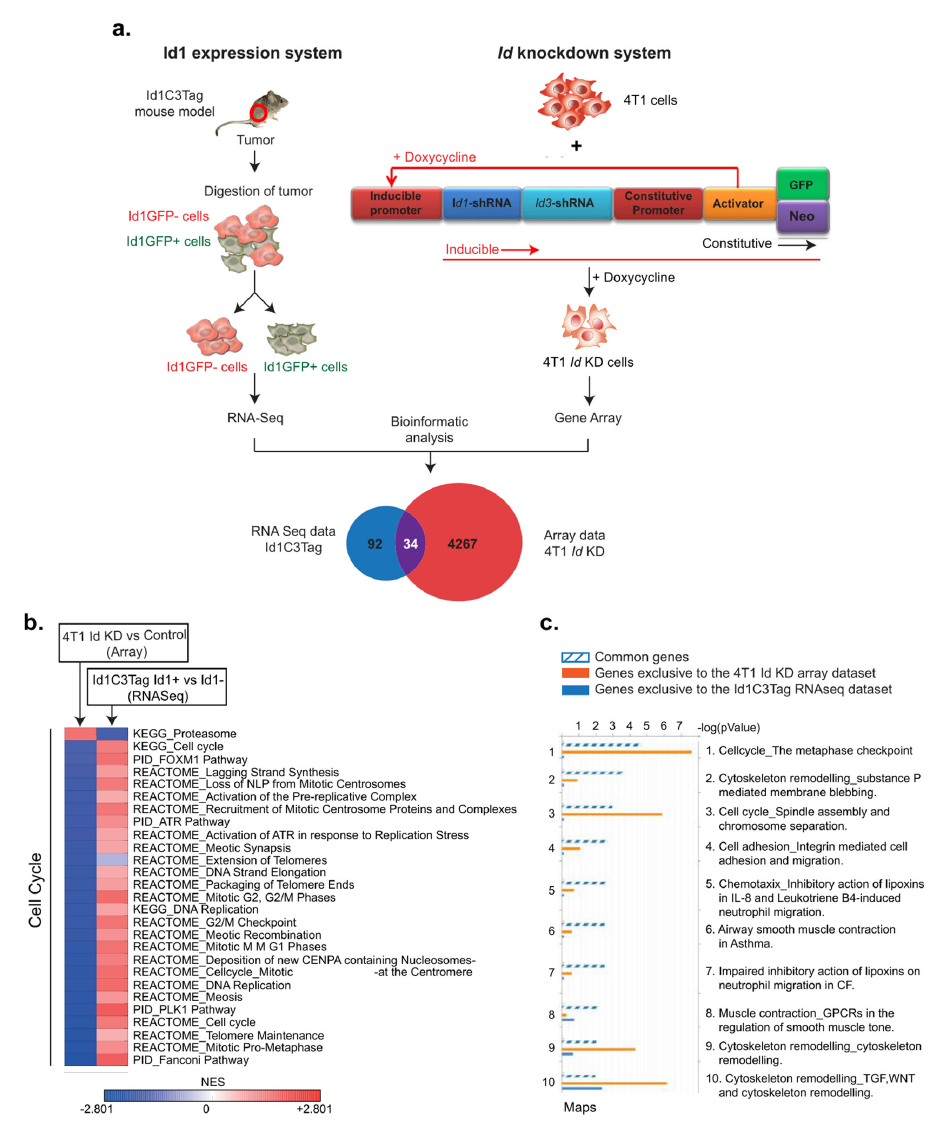
Figure 2. Identification of putative Id-regulated genes. ( a ) To characterize the network of genes regulated by Id proteins, we performed functional annotation analysis on gene array and RNA sequencing data from two different triple-negative breast cancer (TNBC) models marked by either Id depletion or Id1 expression. Aiming to discover high confidence genes involved in the Id gene regulatory network, we compared lists of differentially expressed genes between the Id-expressing or -depleted TNBC models and their controls using MetaCore software. By comparing these two datasets, we generated lists of MetaCore network objects common to both experiments, as well as those unique to each of the two datasets. The data were uploaded in MetaCore and filtered using an adjusted p -value threshold of 0.05, resulting in 4301 network objects that were differentially expressed between the Id KD and the 4T1 control cells. Similarly, the Id1C3Tag RNA sequencing data revealed 126 network objects specific to mouse differentially expressed between Id + and Id- cells. Finally, the genes were mapped to network objects in MetaCore, resulting in a list of 34 genes that were significantly differentially regulated in both models of TNBC. ( b ) To characterize the network of genes regulated by Id, we performed enrichment analysis on the 34 candidate genes, which was visualized by process networks and pathway maps. The enriched pathways included cell cycle, cytoskeleton remodeling, integrin-mediated cell adhesion / migration, and chemotaxis, which are all key steps in epithelial to mesenchymal transition (EMT) and metastasis. ( c ) The cell cycle pathway had the highest score in the genes common to both datasets analyzed, which correlated with the G0 / G1 block observed in Id KD